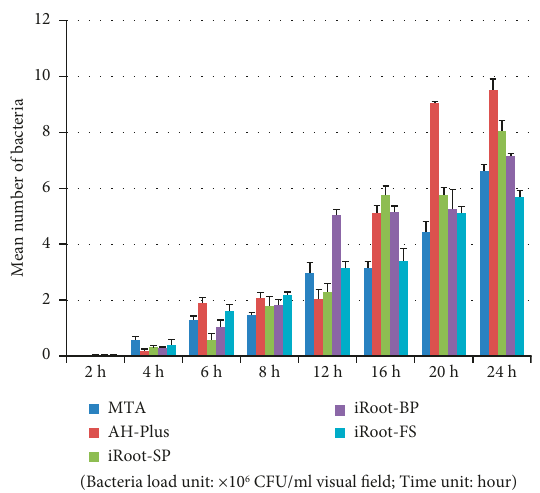
Figure 10: Enterococcus faecalis group (plate colony counting).